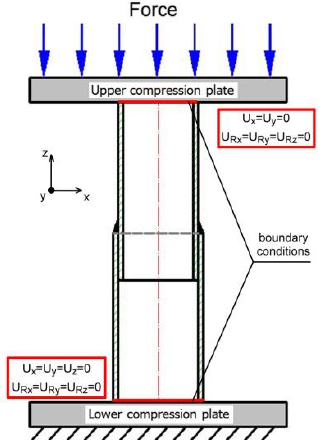
Figure 21. Diagram of the analyzed system during compression test.